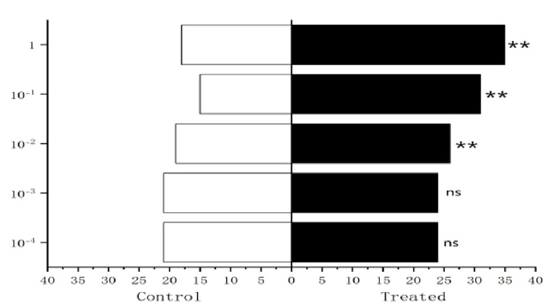
Figure 30. Behavioral responses to methylheptenone in female W. magnifica .